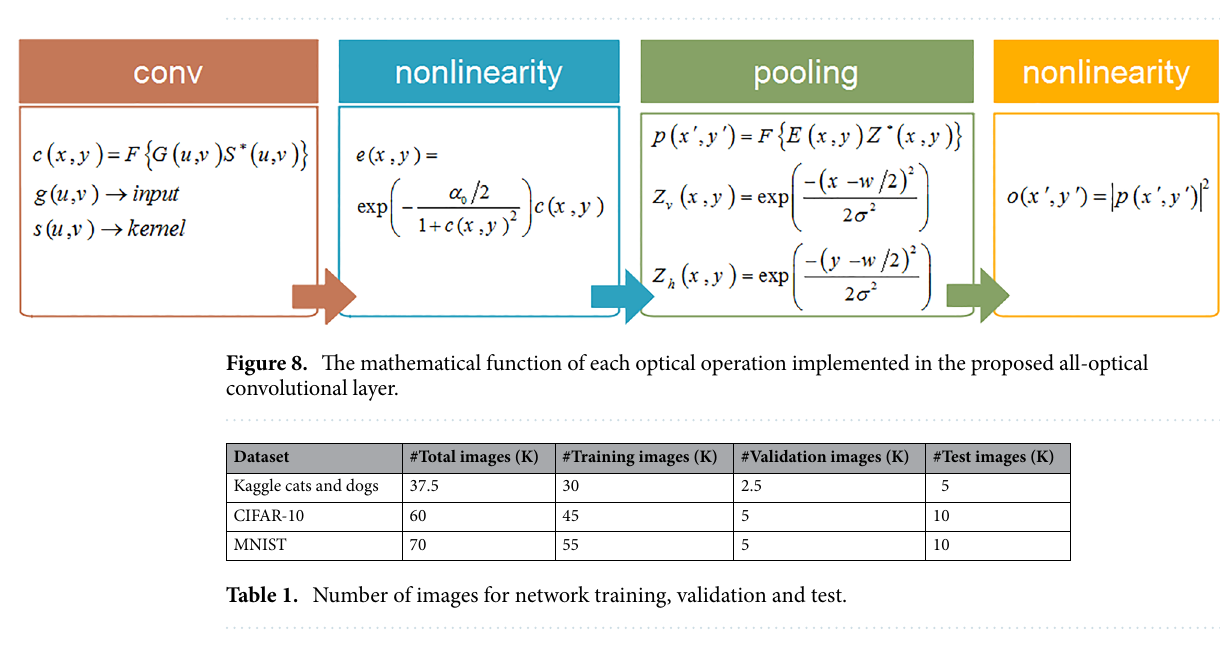
Figure 7. All-optical structure of an operation in first convolutional layer 3 .